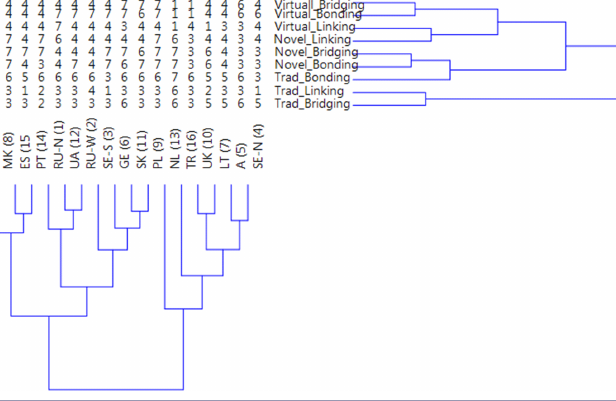
Fig. 8 . Hierarchical clustering using Ward’s method and Euclidian similarity index for 16 hotspot landscapes based on estimates of the strength of bonding, bridging, and linking types of social capitals associated to traditional, novel, and virtual fora in each of them. Data derived from Table